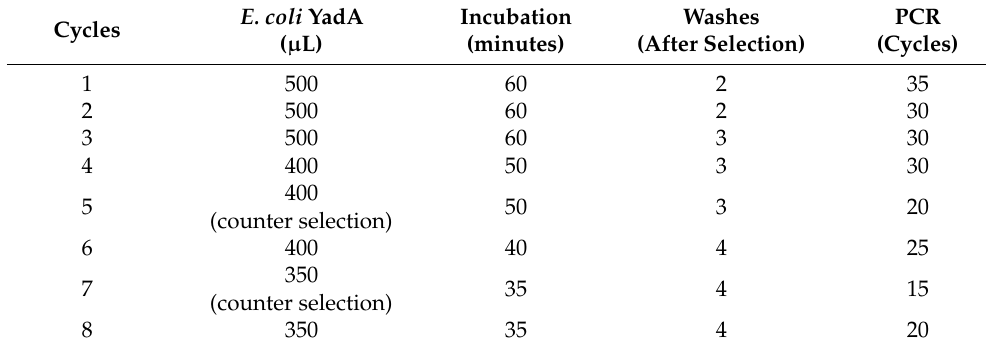
Table 1. Conditions used during the 8 selection cycles of